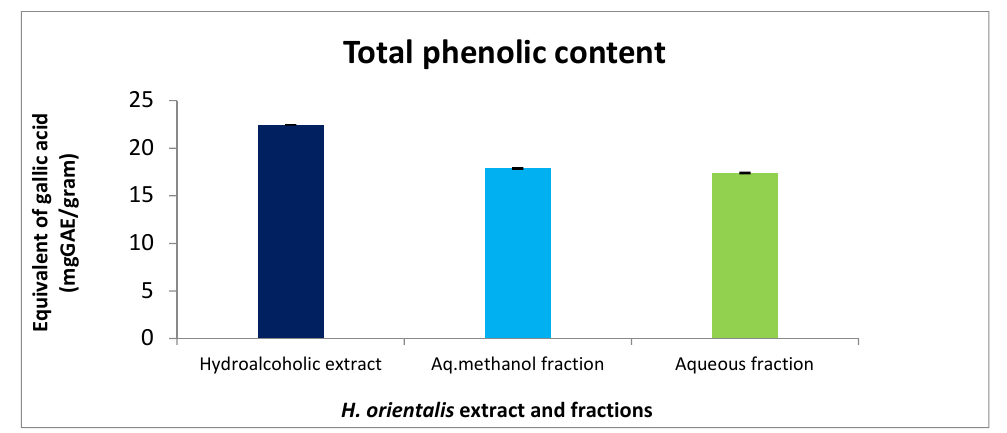
Figure 7. Total phenolic content in mg GAE/g dry weight of H. orientalis L. polar extract and fractions at concentration 100 mg/mL. Hydroalcoholic extract showed the highest value (22.4 mg GAE/g dry weight). Results are expressed as means of three independent experiment (bars) ± SEM (lines).